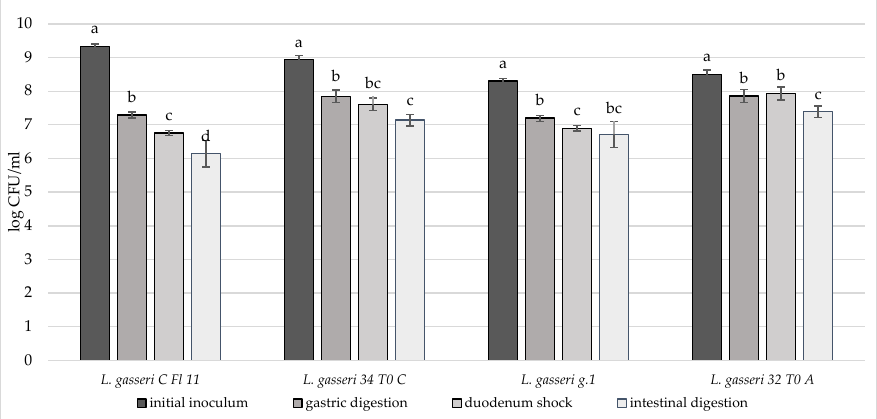
Figure 5. Cell loads of L. gasseri CFl11, L. gasseri 34T0C, L. gasseri g.1, L. gasseri 32T0A after the sim- ulated stomach–duodenum passage, performed immediately after the inoculation in milk. Samples with different letters are significantly different ( p < 0.05).